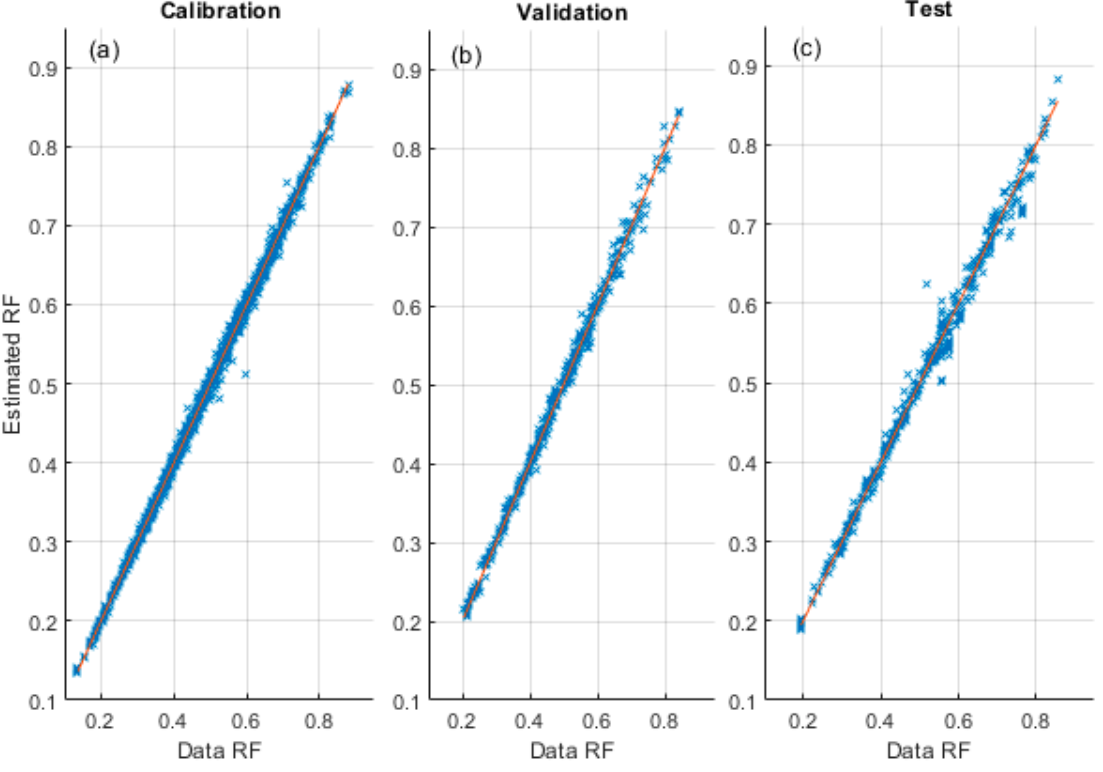
Figure 6. Comparison of estimated RF and actual datapoints on ( a ) the training set, ( b ) validation set and ( c ) test set. Estimated points are based on MOD2 (optimized LSSVM). The orange line represents perfect match.